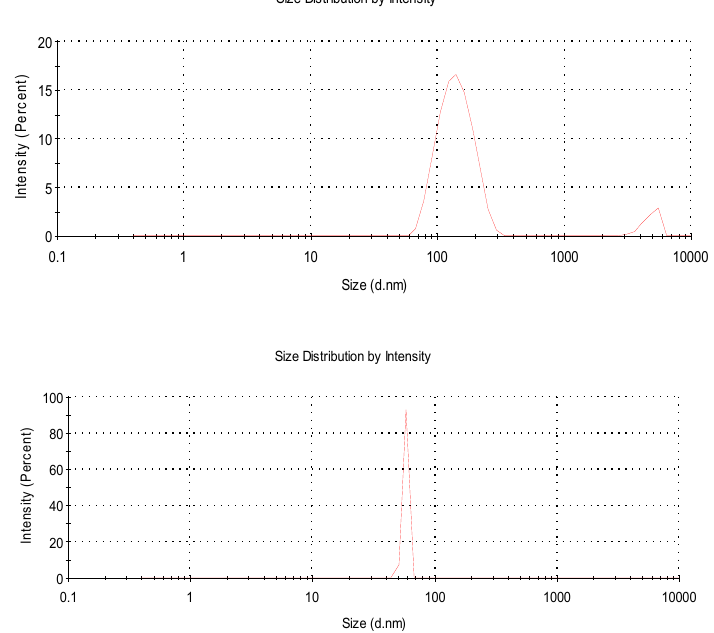
Figure A2. Hydrodynamic size determination of green-synthesized Ag NPs of C. roseus (upper panel) and A. indica (lower panel), as determined by dynamic light scattering